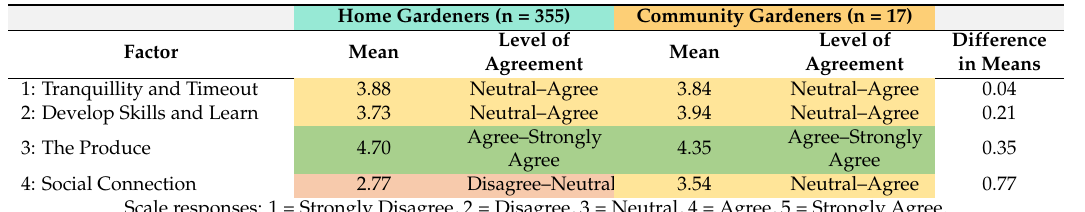
The comparison of the home and community gardener level of Factor agreement. The colour coding is as follows: yellow for neutral–agree, red for disagree–neutral and green for agree–strongly